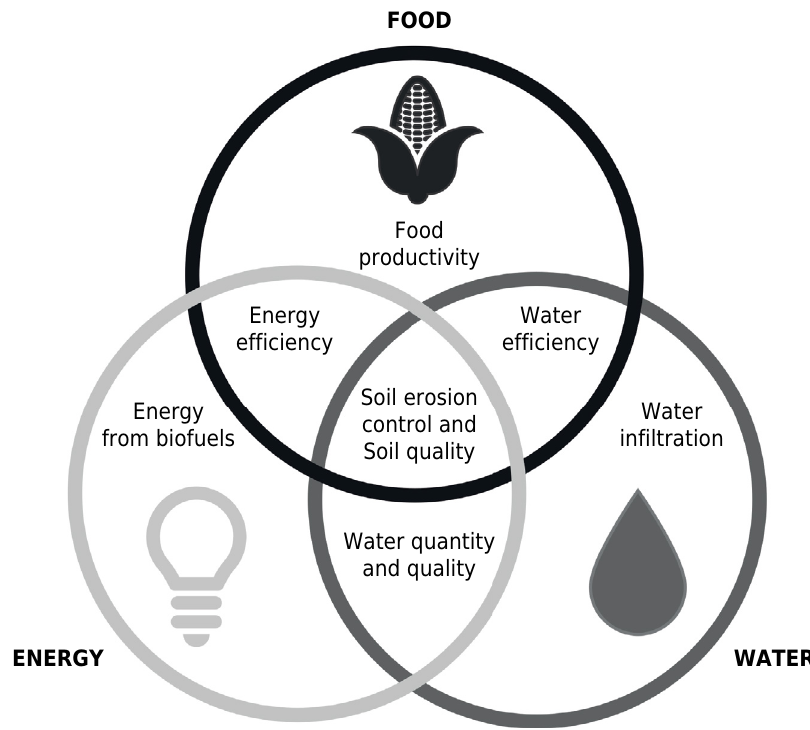
Figure 1. Linkages among attributes and F-W-E